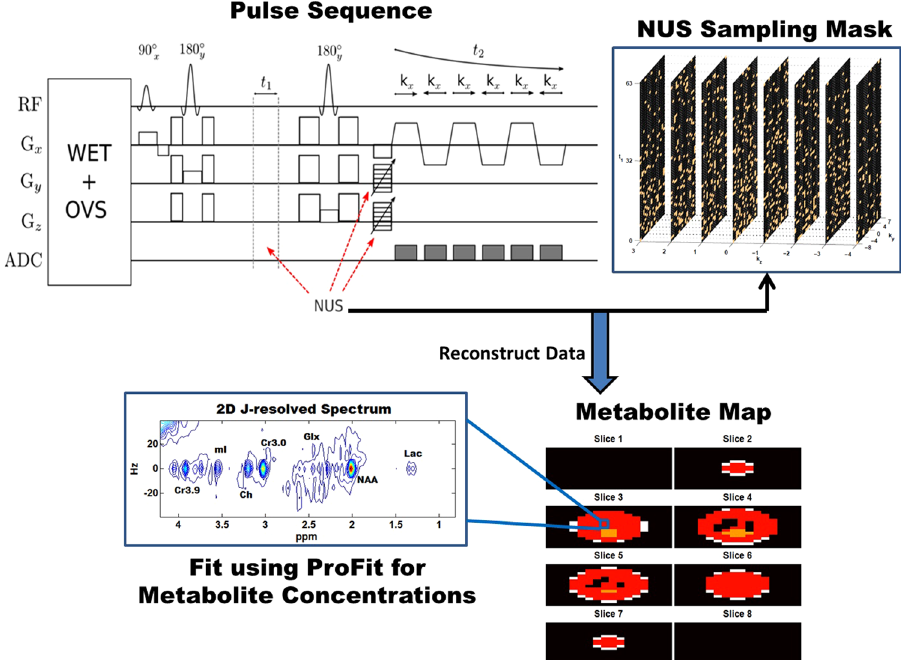
Figure 1. The 5D EP-JRESI acquisition and quantitation methods are shown. First, the data are acquired using the 5D EP-JRESI sequence, which utilizes a 90°–180°–180° pulse sequence for volume localization. The non- uniform sampling scheme is applied to the three incremented dimensions: ( k y , k z , t 1 ), and the copper points are sampled. After acquisition, the data are reconstructed using eq. (2) as described in the text. Following reconstruction, the metabolite maps can be displayed and voxels of interest can be chosen. Finally, these voxels, which contain 2D J-resolved spectra, can be quantified using ProFit to yield metabolite